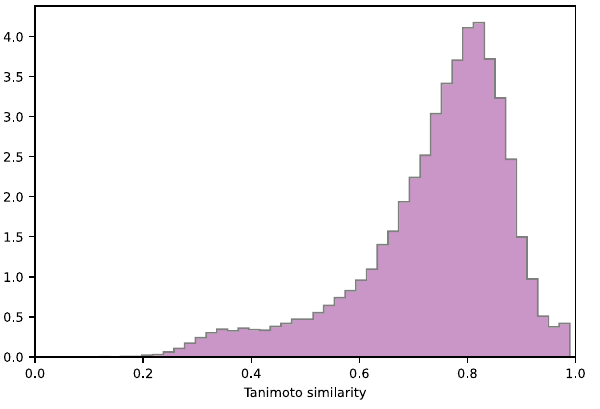
Figure 7. Tanimoto similarity of molecules which are nearest neighbors in the training dataset.